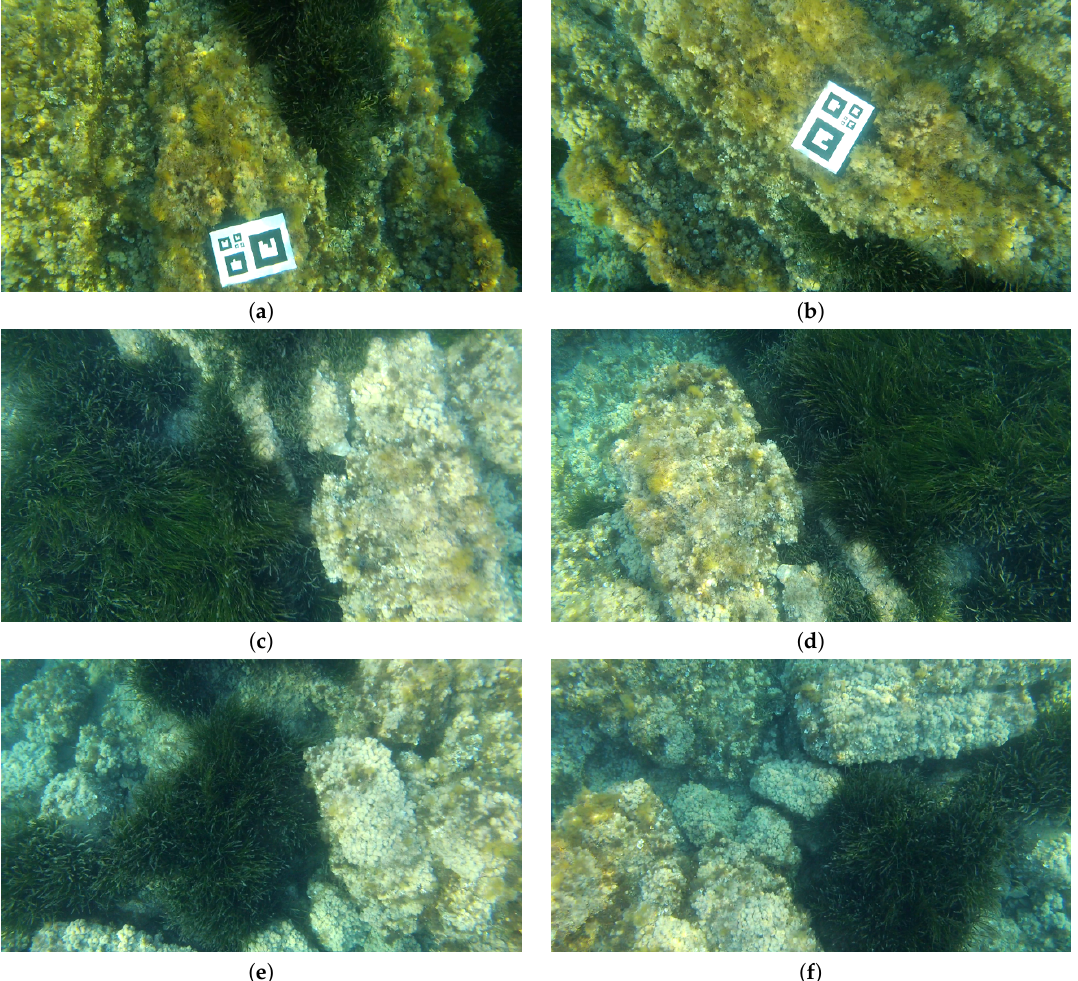
Figure 8. Local loops of sequences V 1 and V 2: Each image in the left column closes a loop with the corresponding image in the right column. ( a , b ) Sequence V 1, Image 10 with Image 155. ( c , d ) Sequence V 1, Image 143 with Image 27. ( e , f ) Sequence V 2, Image 119 with Image